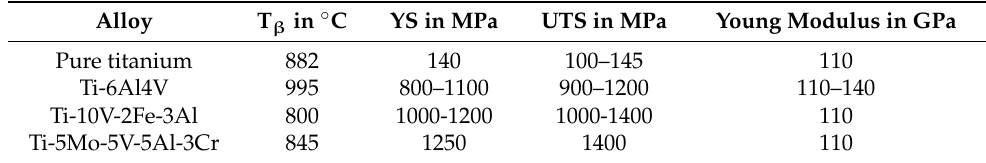
Table 1. Mechanical properties of different Ti alloys [13,27]. Table 1 . Mechanical properties of different Ti alloys [13,27] .